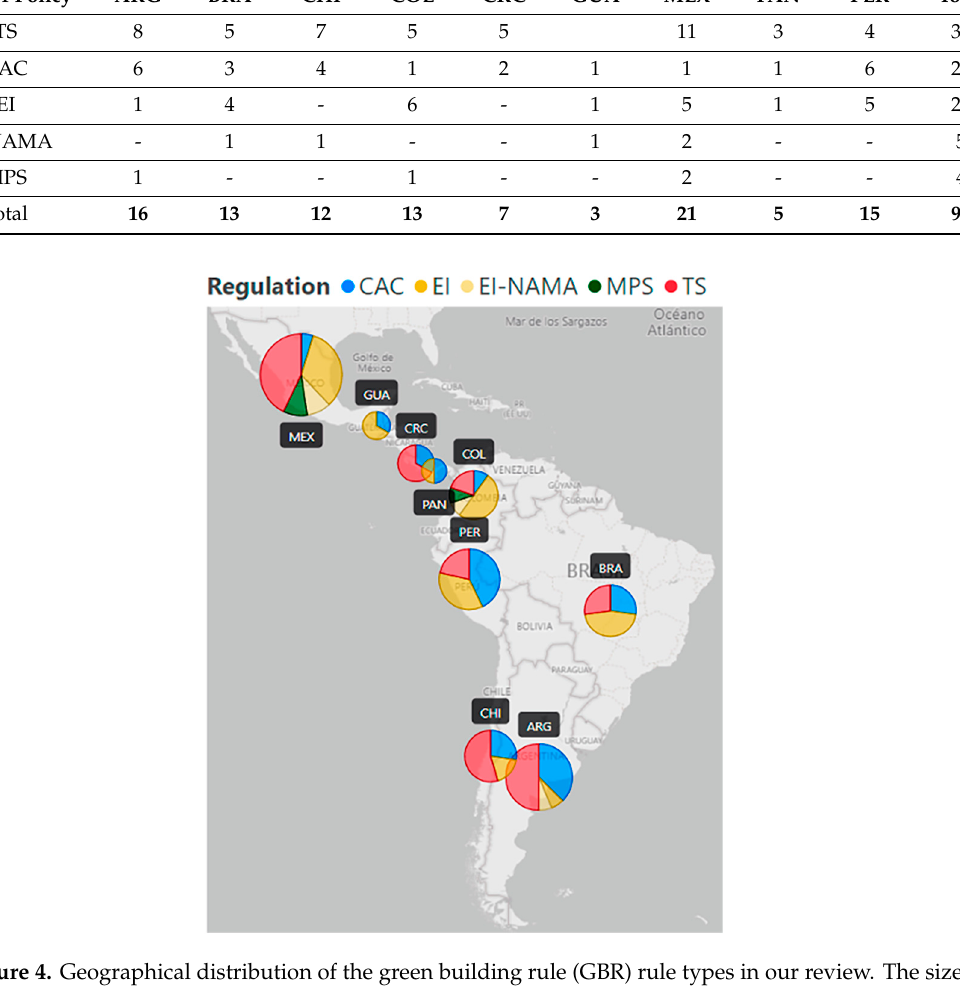
Figure 5. Chronology of the green building rules launched. Each number indicates the GBRs promulgated in a given country (coded by colour) in a given year.